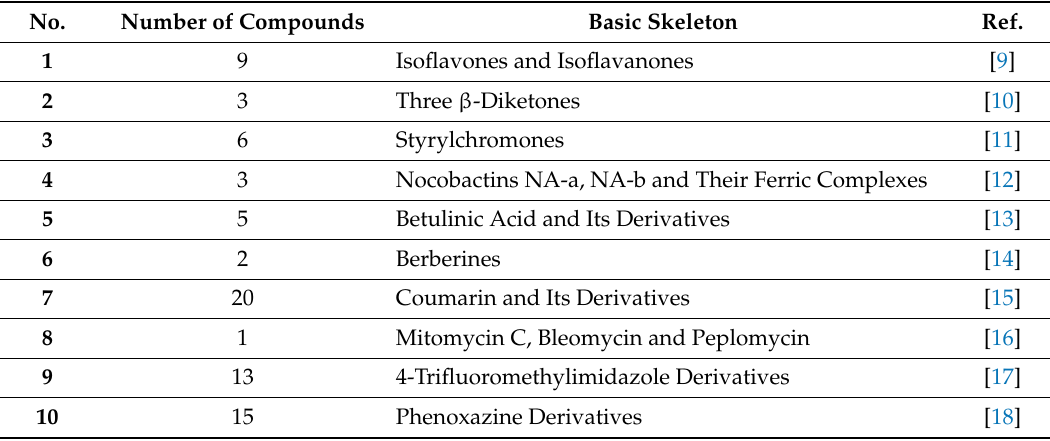
Table 2. Number of compounds and basic skeleton extracted from articles.